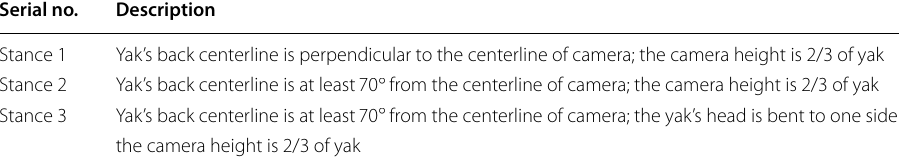
Table 3 Definitions of yaks’ 3